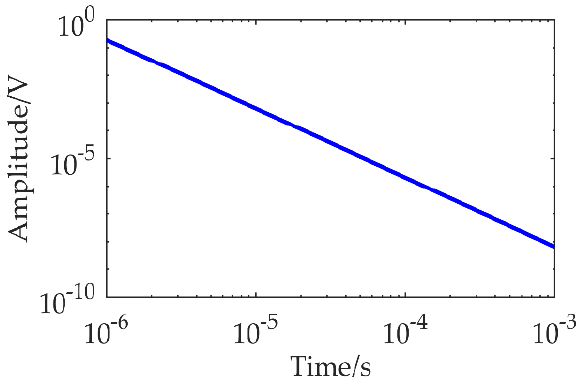
Figure 2. The TEM forward response.